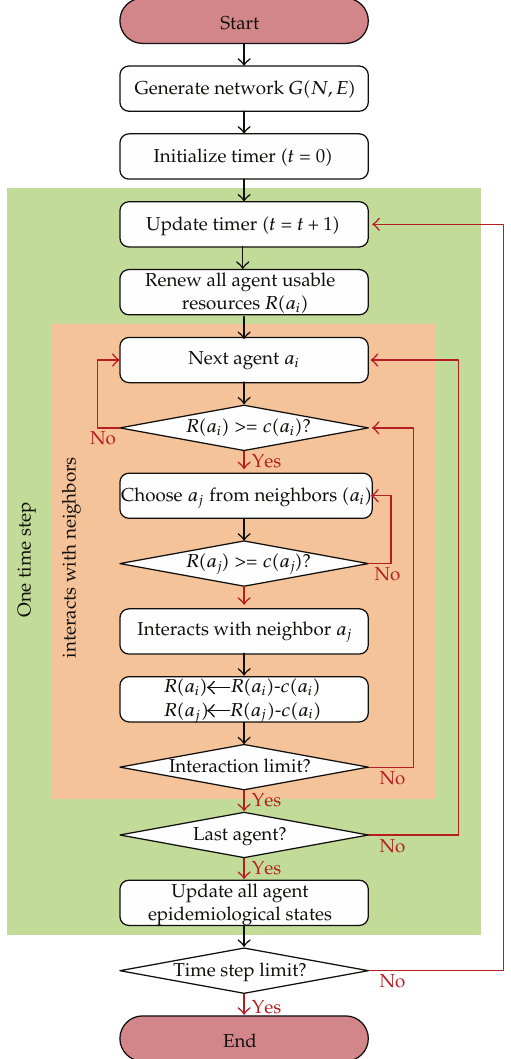
Figure 2: Simulation